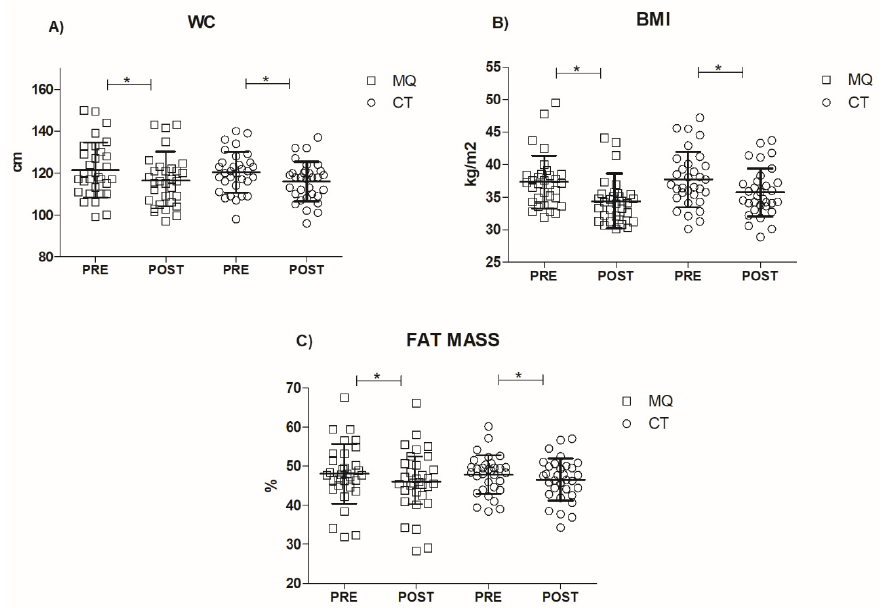
Significant main effect of time before and after testing ( p < 0.05). # Significant interaction ( p < 0.0001).